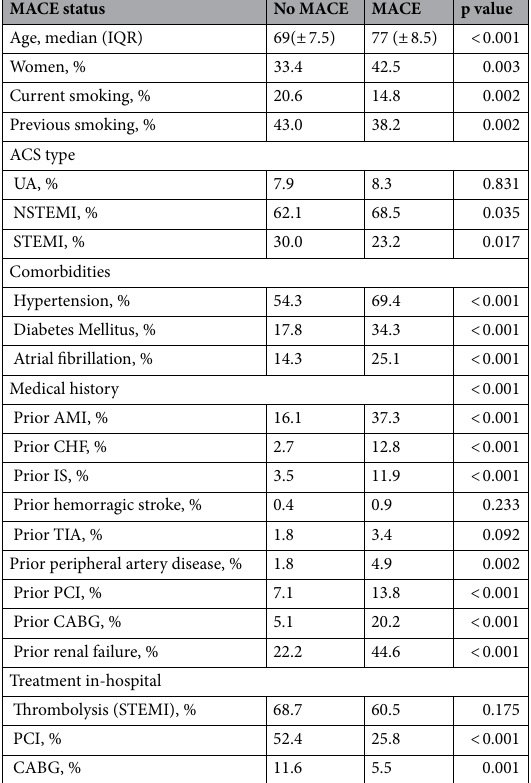
Table 5. Patient Characteristics among 1379 patients discharged after hospitalization for ACS according to the occurrence of MACE during the entire follow-up period. NSTEMI non ST-segment elevation myocardial infarction, STEMI ST-segment myocardial